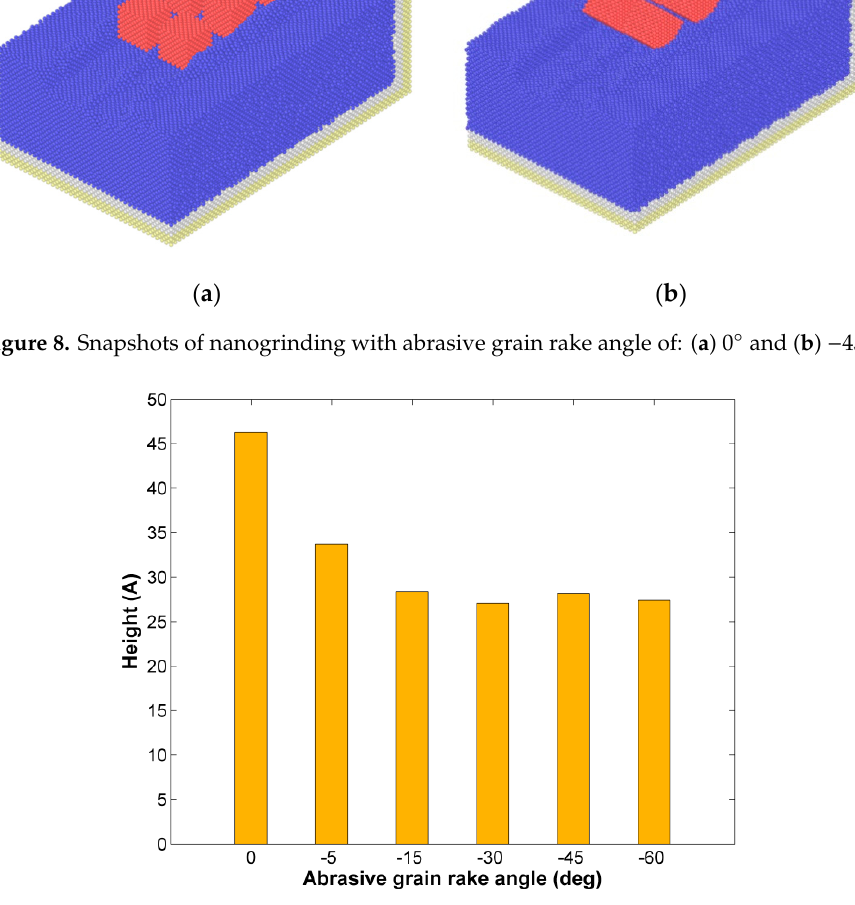
Figure 10. Number of atoms pertinent to partial dislocations and stacking faults in respect to abrasive grains rake angle.